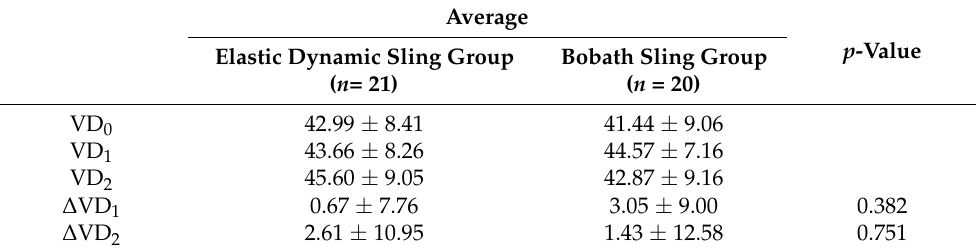
Table 2. Difference of vertical distance between the elastic dynamic sling group and the Bobath sling group.